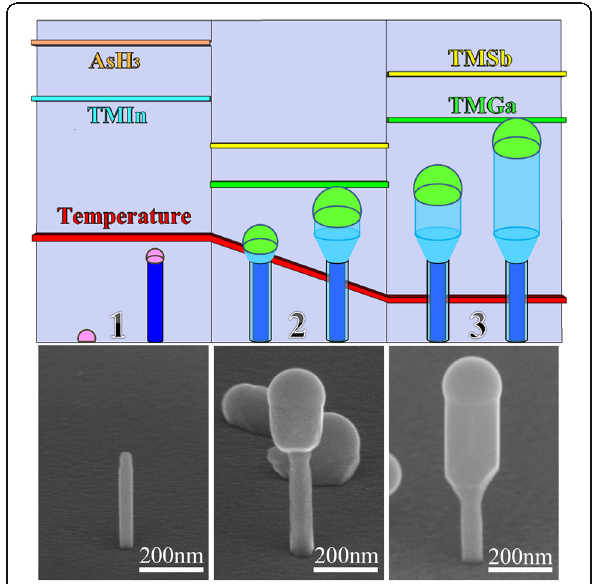
Fig. 1 The illustration of the axial growth of GaSb nanowires on InAs stems and the source-supply sequences for the growth of the nanowires. The GaSb nanowires presented here were grown at 520